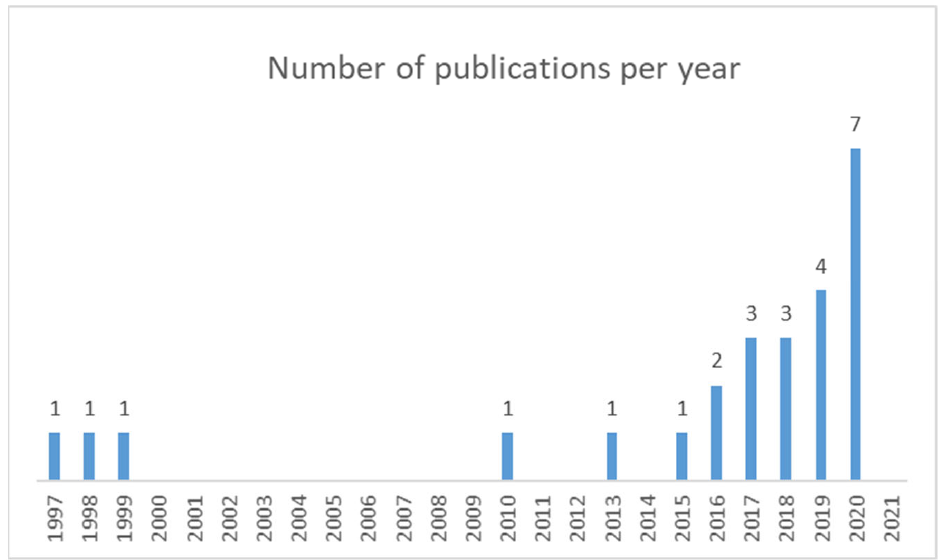
Figure 2. Timeline distribution of the articles included in the systematic review.